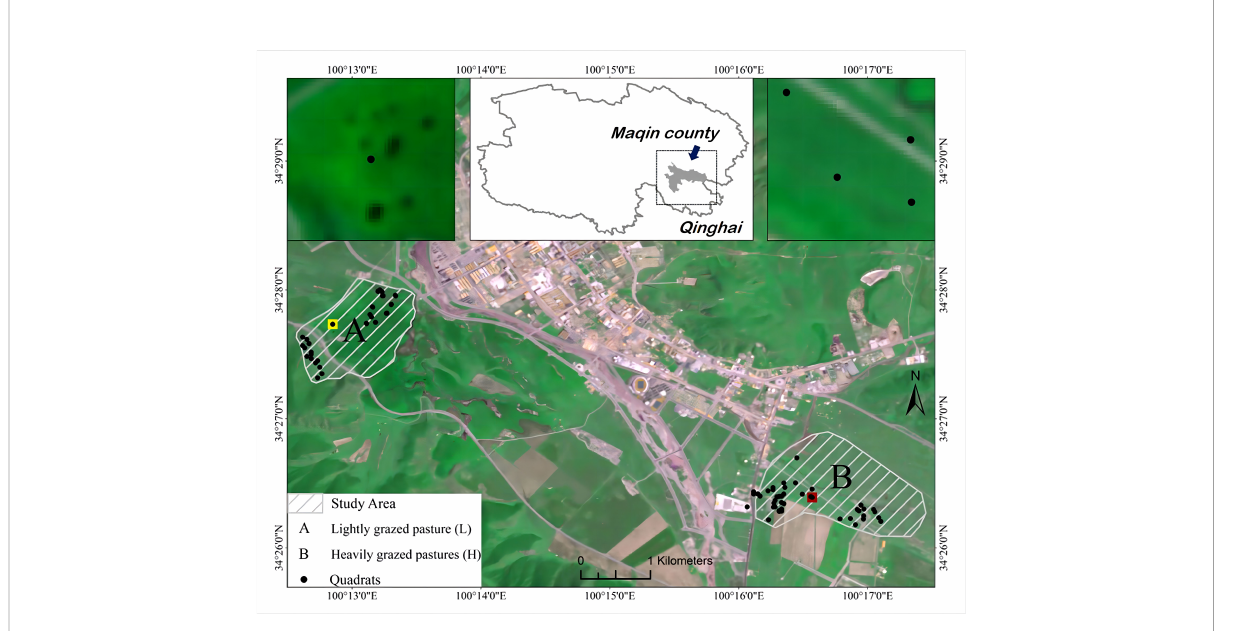
FIGURE 1 Design of the sample